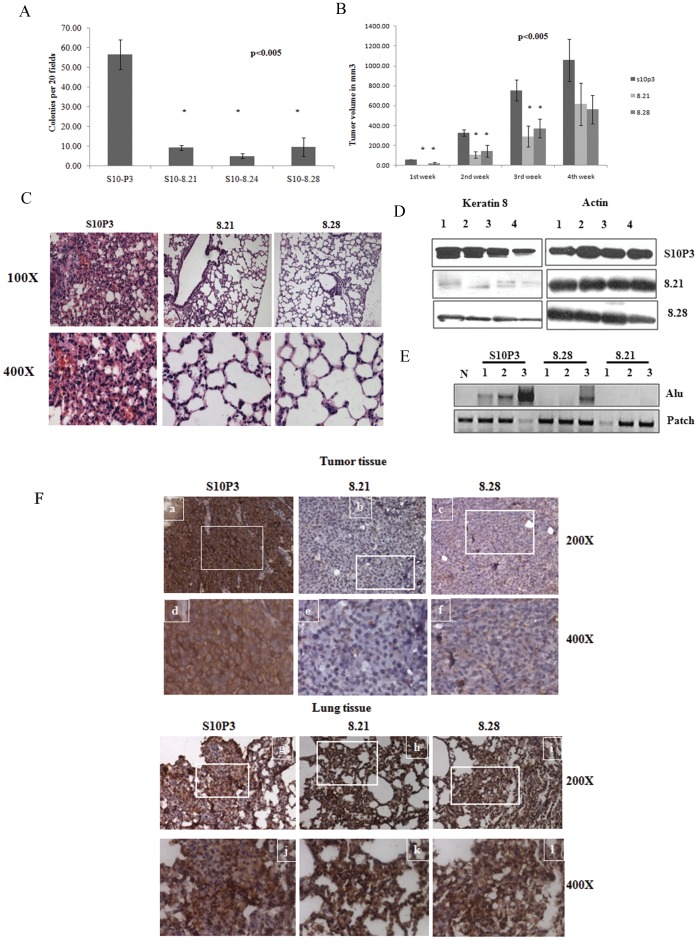
K8 downregulation leads to an inhibition of transformation in vitro and in vivo.
A. The S10 derived K8 (8.21, 8.24 and 8.28) knockdown clones or the vector alone (S10P3) were plated in soft agar and colony formation determined after 2–3 weeks. The number of colonies formed by the clones per 20 low power fields (10X) was counted in triplicate in each experiment and the mean and standard deviation of three independent experiments is plotted as shown. B. 106 cells from the S10 derived K8 (8.21 and 8.28) knockdown clones or the vector alone (S10P3) were injected subcutaneously into 5 different nude mice and tumor size determined every week as described. Tumor volume is plotted on the Y-axis and the time in weeks on the X-axis. C. Protein extracts from primary tumors from mice injected with the S10 derived K8 (8.21 and 8.28) knockdown clones or the vector alone (S10P3) were resolved on SDS-PAGE gels followed by Western blotting with antibodies to K8 and β-actin. The numbers indicate different mice injected with the single or double knockdown clones. All the samples were run on the same gel and the Western blots performed at the same time. D. Haematoxylin and eosin staining of paraffin embedded sections of lung tissue from nude mice injected with 106 cells of the vector alone (S10P3) or the double knockdown clones (8.21 and 8.28). Lung section from mice injected with S10P3 cells show extensive metastasis with thickening of alveolar walls from deposition and aggregation of metastasized tumor cells, whereas lungs from mice injected with the double knockdown cells show normal lungs with thin walled alveoli, with a few metastatic tumor cells. The images in the top row are at magnification x100 and images in the bottom row are at magnification x 400. E. PCR reactions were performed on DNA isolated from paraffin sections for the presence of Alu repeats in genomic DNA. Genomic DNA was purified from normal lung tissue, lung tissue from mice injected with cells with PKP3 knockdown alone (S10P3) and lung tissue from mice injected with the double knockdown clones (8.21 and 8.28). Lung tissues from uninjected mice (N) were used as a negative control for the Alu PCR. A PCR for the mouse patch gene was performed as a loading control. F. Immunohistochemical staining was performed with antibody against K8 on sections of paraffin embedded tissue of tumor and lungs of mice injected with S10P3 vector control cells or the double knockdown clones, 8.21 and 8.28. Images a, b, c, g, h and i are taken at a magnification x 200 and the respective magnified images at magnification x 400, of the indicated areas in the white rectangles, are represented by images d, e, f, j, k and l. Tumor tissue from mice injected with S10P3 (a and d) show K8 staining at levels higher compared to tumors from mice injected with the double knockdown clones, 8.21 and 8.28 (b, c, e and f). In contrast lung tissue, from mice injected with the vector control S10P3 cells (g and j) and the double knockdown clones (8.21 and 8.28) (h, i, k and l) show elevated K8 staining in metastatic areas of the lungs with infiltrated tumor cells.